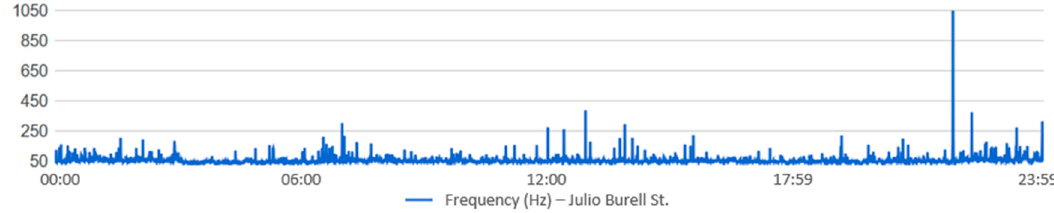
Figure A4. The predominant frequency during 15 November 2016, at Julio Burell Street.